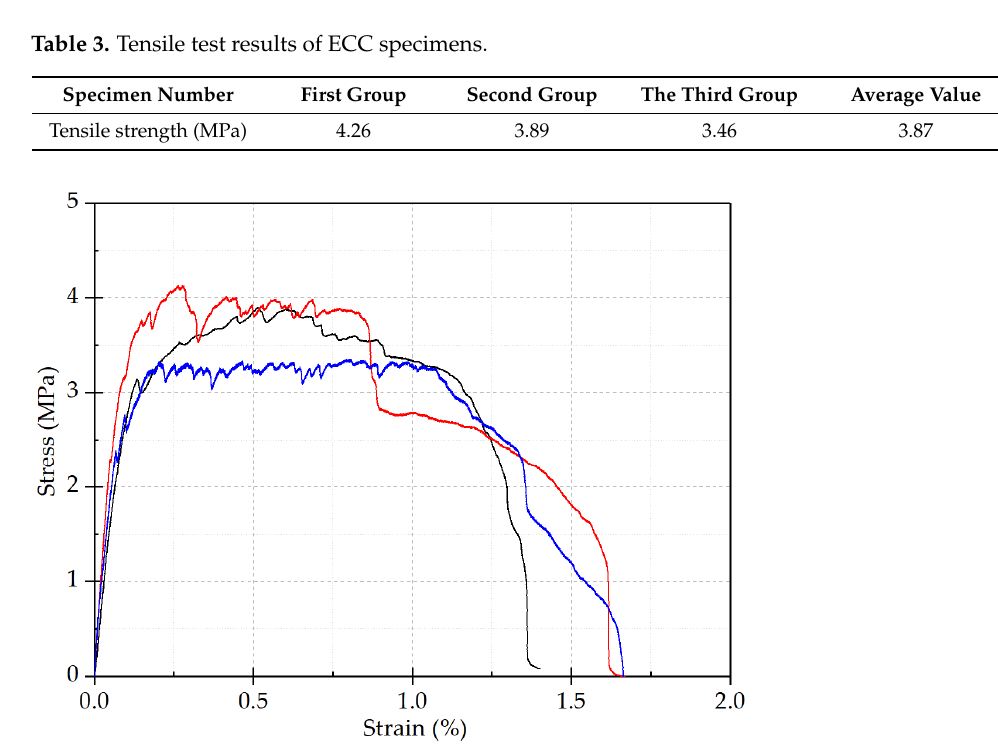
Figure 5. ECC tensile stress–strain curve.